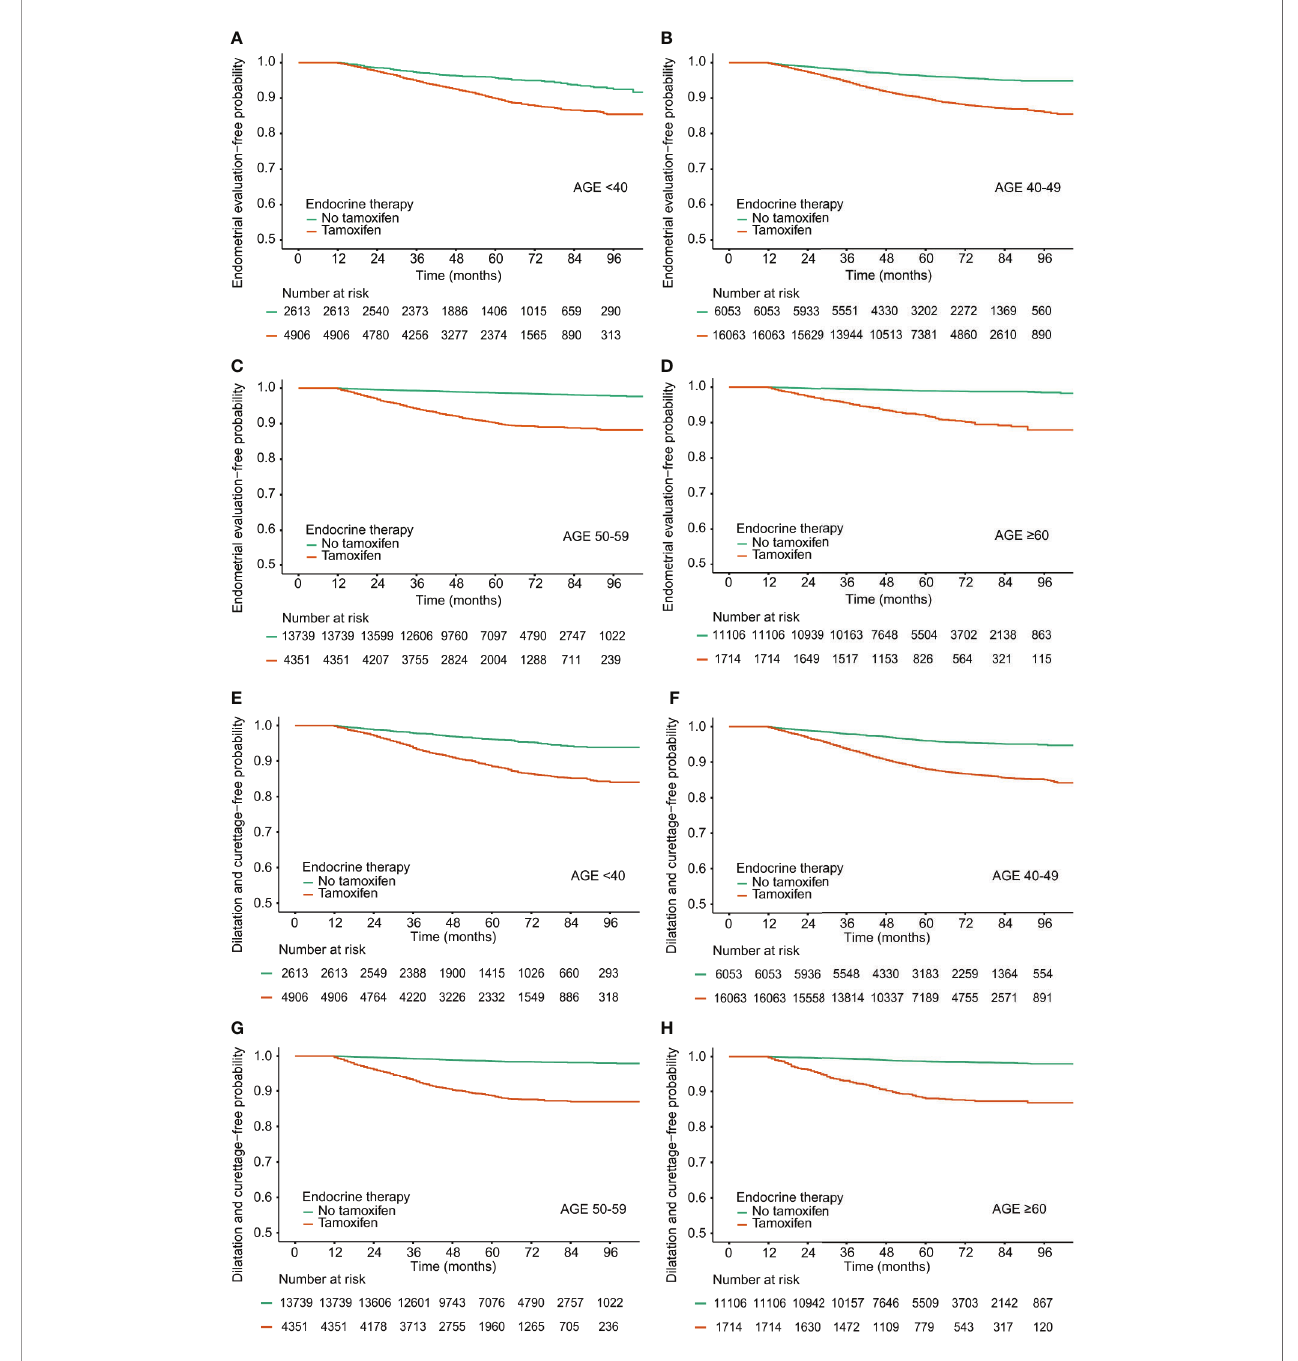
FIGURE 2 | Procedure-free probability in breast cancer survivors by tamoxifen and age at diagnosis. (A – D) Endometrial evaluation, (E – H) Dilatation and